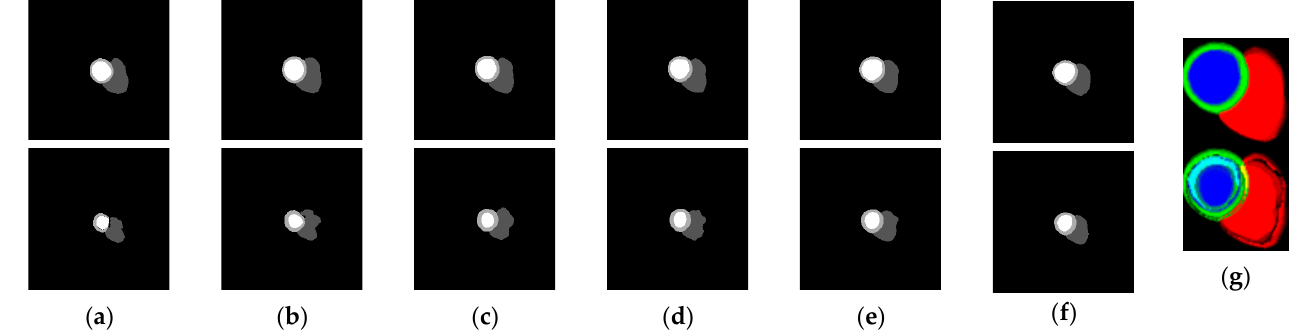
Figure 4. Segmentation output maps ( a – f ) of short-axis slices 1–6 of each ED ( top ) and ES ( bottom ) frames processed by the 2D thickness algorithm to produce 2D images ( g ) for few-shot model input.